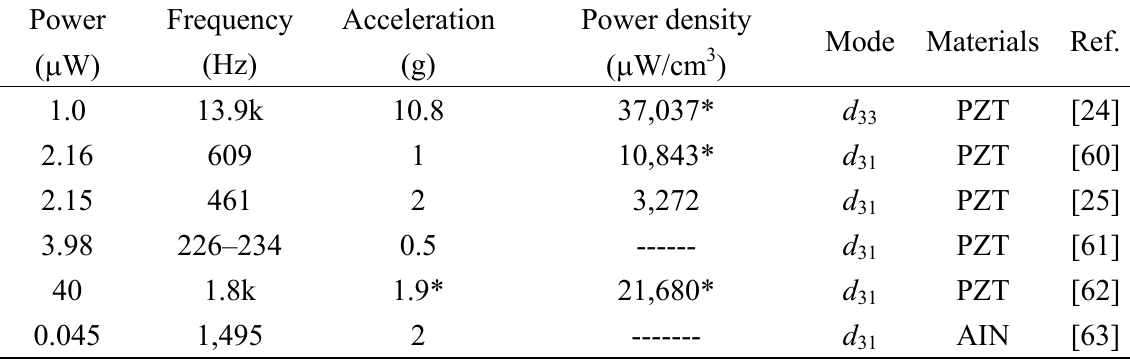
Table 2. Characteristics of reported piezoelectric